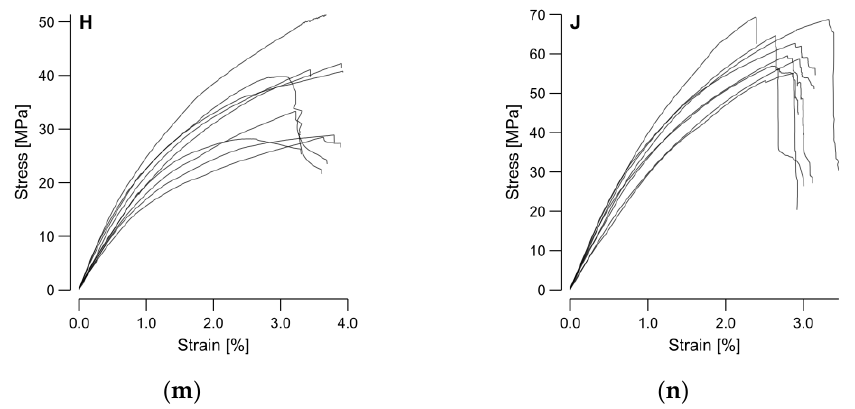
Figure 10. Stress – strain diagrams of the four-point bending tests for each induvial sample set. ( a ) Figure 10. Stress–strain diagrams of the four-point bending tests for each induvial sample Carbon — C; ( b ) carbon with petroleum-based resin — C*; ( c ) E-glass — G1; ( d ) S-glass — G2; ( e ) basalt,